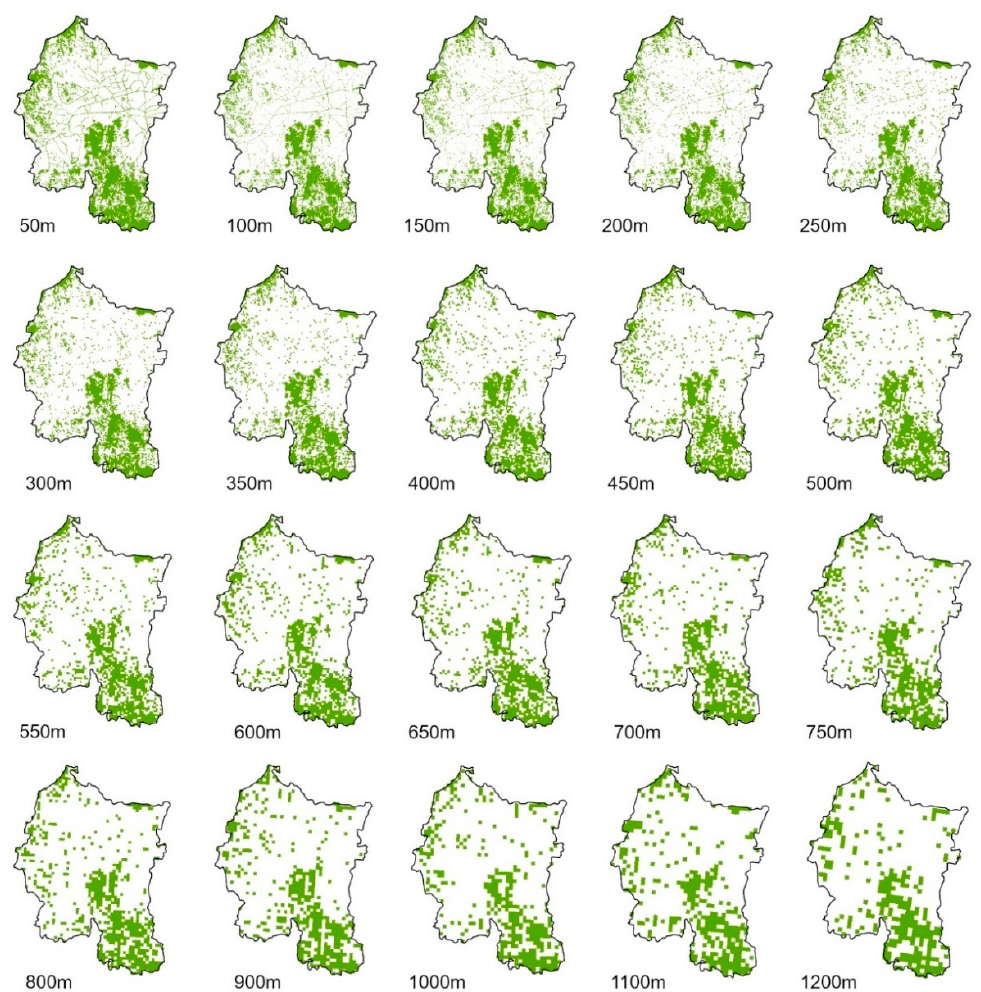
Figure 4. Ecological land at different granularity levels.